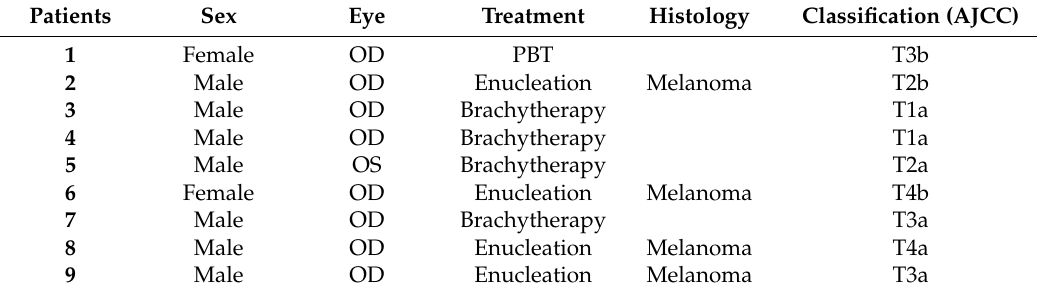
Table 1. Patients’ data regarding sex, eye involved, treatment, histology in case of enucleation and classification according to the AJCC. OD—oculus dexter, OS—oculus sinister , PBT—proton-beam therapy , AJCC—American Joint Committee on